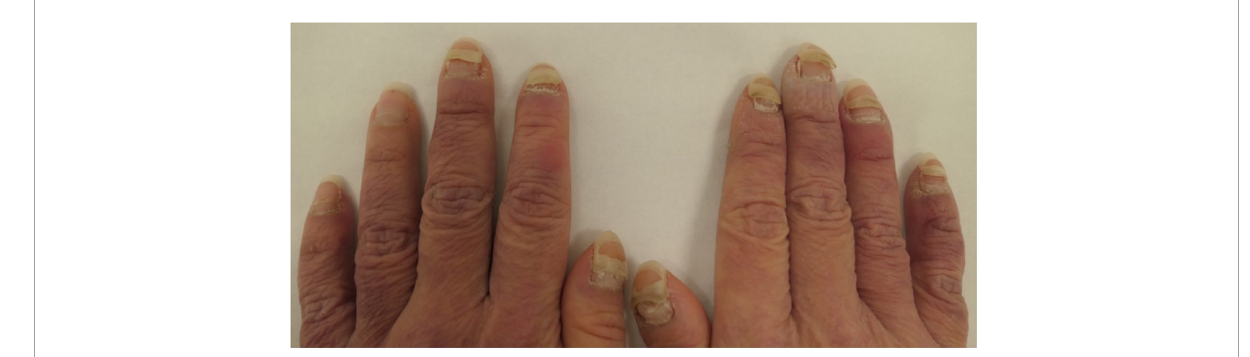
FIGURE2 Severe pemphigus vulgaris induced by a COVID-19 vaccination with extensive